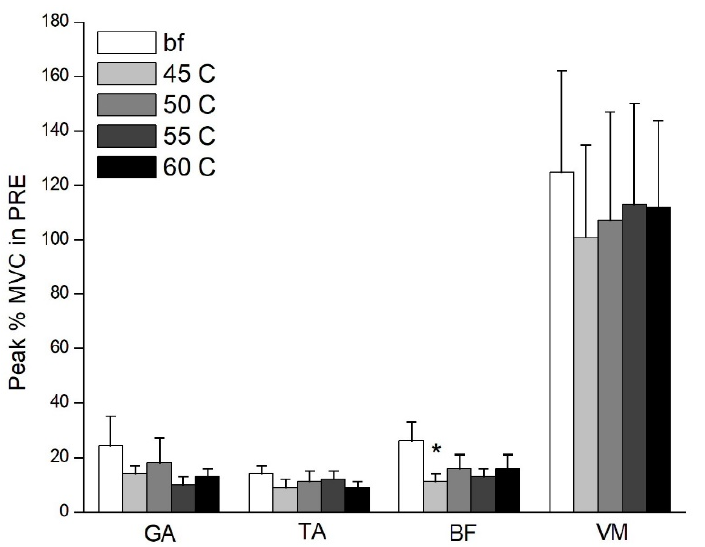
Figure 3. Peak %MVC of lower extremity in PRE stage. bf = barefoot. * Indicates significant difference with barefoot ( p < 0.01).